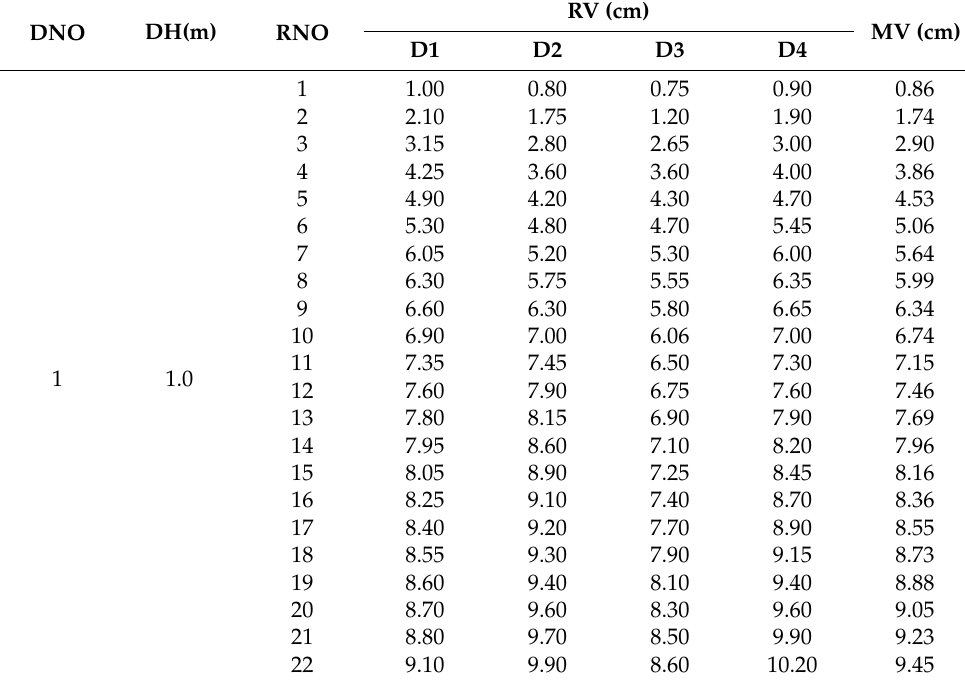
The data of Chinese fir stem disks was used as the test data set, and two stem disks were selected. Three people measured the annual ring radius data. The average value measured by three people was used to compare the accuracy with the subsequent tree ring radius identification data, to verify the practicability of the technical method in this study. The data are shown in Table 2. Table 2. Radius measurement dataset of Chinese fir stem disk. DNO is the number of the sample of the stem disk. DH is the height of the stem disk at the trunk; RNO is the number of the growth ring (starting at the pith); D1, D2, D3, and D4 represent four measurement directions; RV is the value of the radius of the ring; MV is the mean of the ring radius in the four